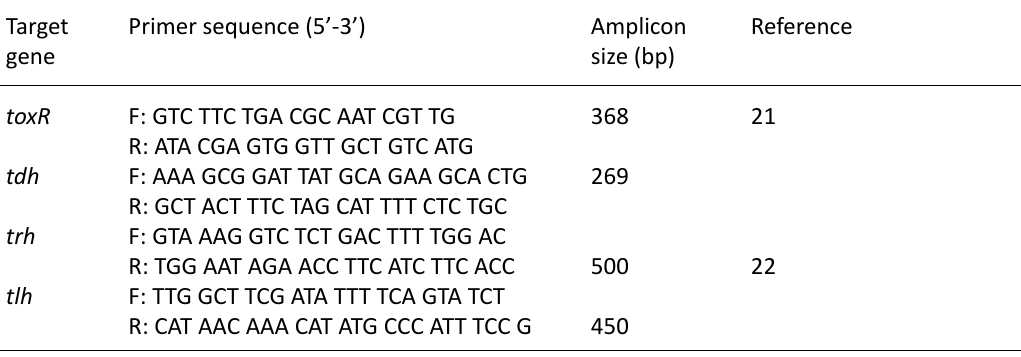
table 1. Oligonucleotide primers used in the study